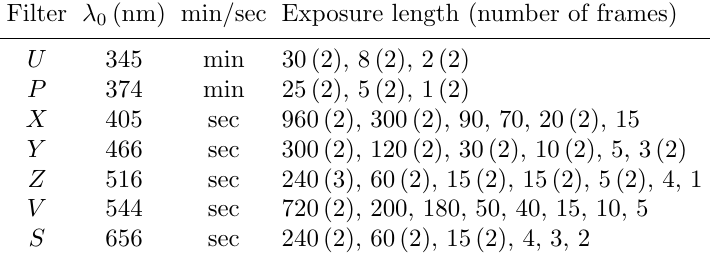
Table 1. Log of observations. The (cid:12)rst two columns give the (cid:12)lter name and its mean wavelength. The numbers of multiple frames with the same exposure length are given in